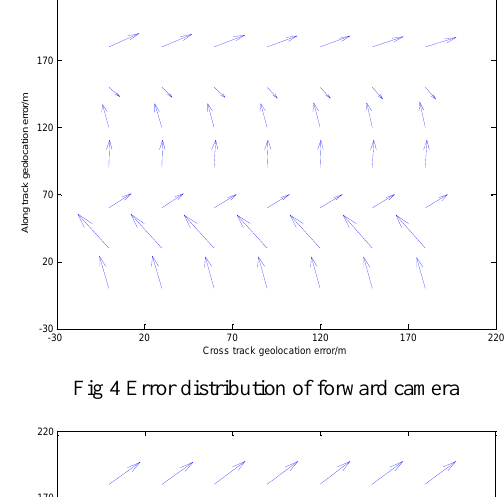
Fig 4 Error distribution of forward camera